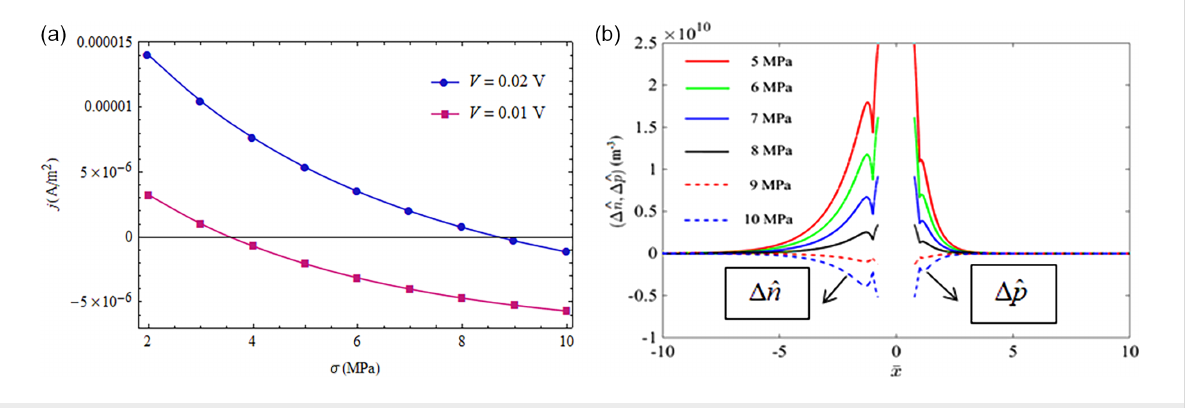
Figure 5: (a) Current density as a function of applied tensile stress under two constant forward-bias voltages; (b) NEMC under different tensile stresses at V = 0.02 V.